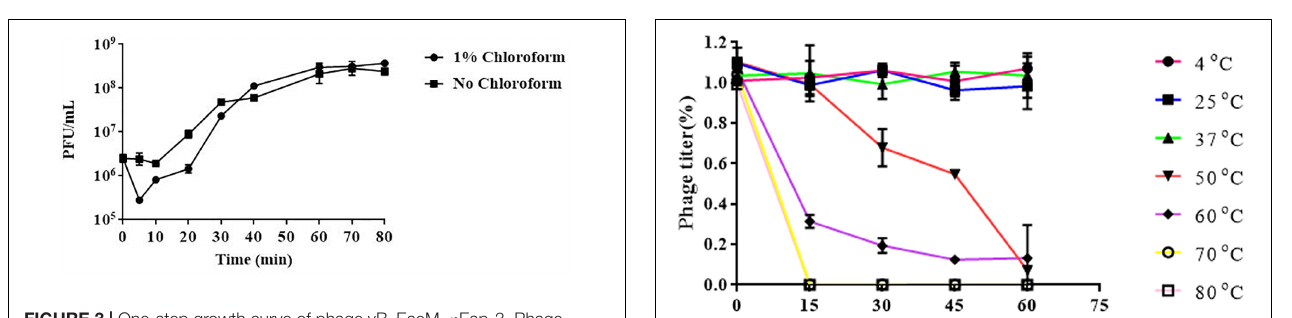
FIGURE 3 | One-step growth curve of phage vB_EaeM_ ϕ Eap-3. Phage vB_EaeM_ ϕ Eap-3 was grown in an exponential phase culture of Enterobacter aerogenes strain 3-SP. Data points indicate the PFU/mL at different time points. Each data point represents the mean of three independent experiments.